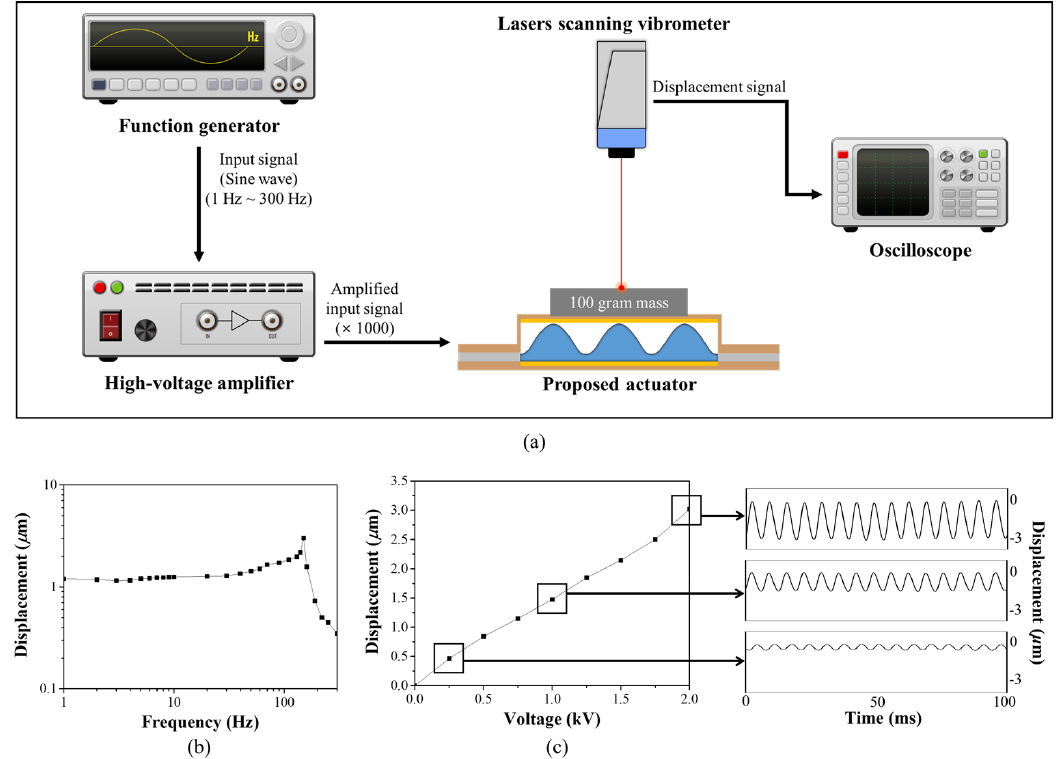
Figure 10. ( a ) Experimental environment for investigating the displacement of the proposed actuator; ( b ) the displacement of the proposed actuator according to the input frequency; and ( c ) displacement as a function of input voltage at the resonant frequency.